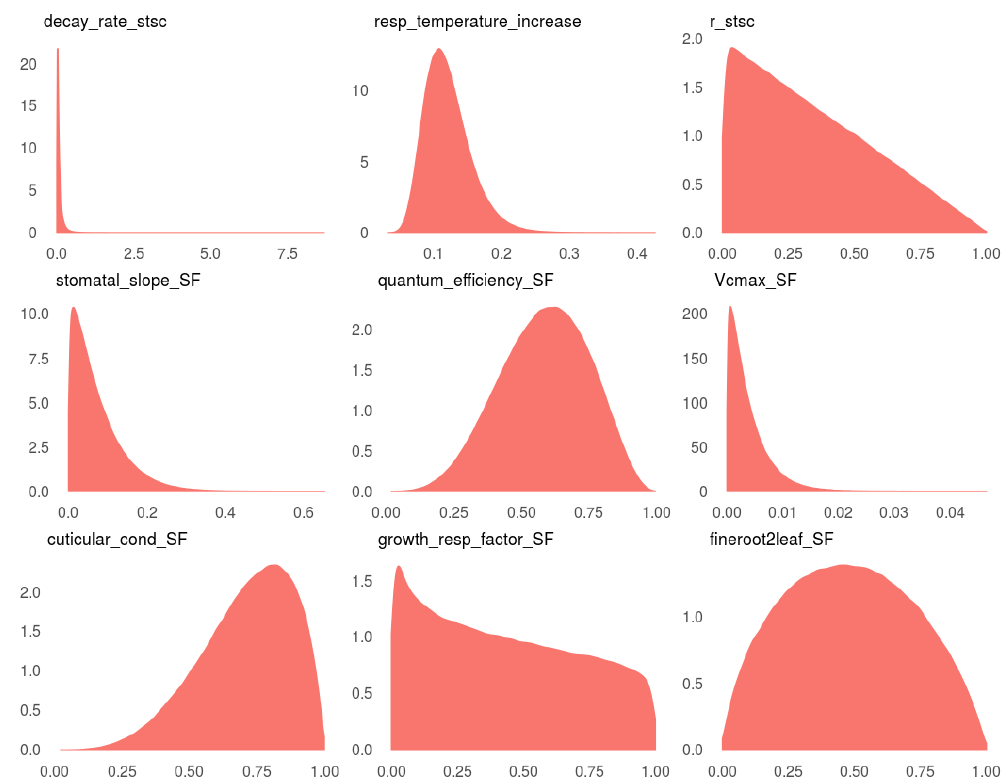
Figure A5. ED2 decomposition and scaling factor posterior density distributions. Parameters common to all ED2 PFTs ending with the suffix “SF” were targeted through the scaling factor.